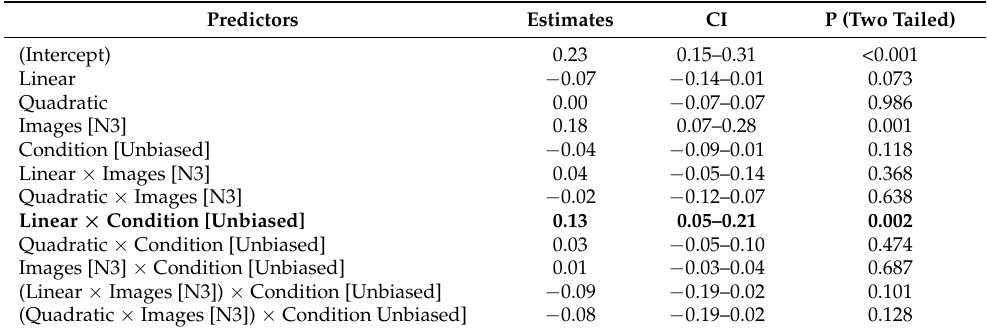
Table 9. Results of GCA analysis of IWA data for time window 4 (processing N2 relative to